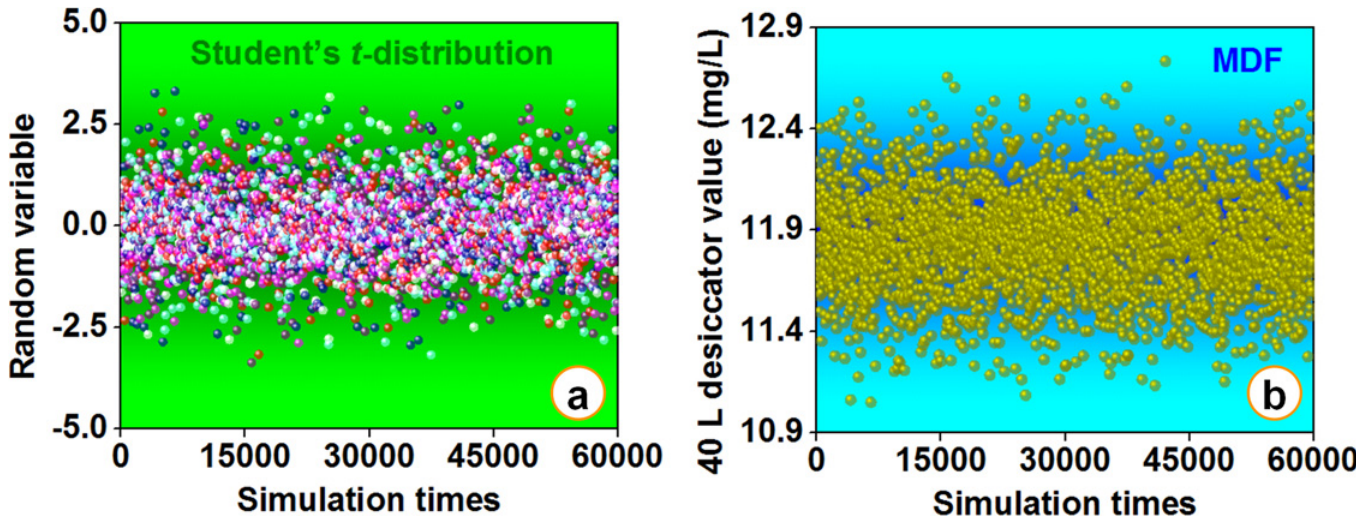
Fig 12. A large scale simulation survey for formaldehyde emissions of various materials in standard tests of the Chinese national standard GB 18580. (a) The random variable p i values ( i = 1 to 60,000) subject to the Student ’ s t -distribution generated by the computer. (b) An illustrative example of the large scale simulation survey, i . e ., the simulated μ i values ( i = 1 to 60,000) of the 40 L desiccator test for the medium density fiberboard (MDF), in which the μ i values ( i = 1 to 60,000) represented the formaldehyde emission value characterized by the 40 L desiccator method.